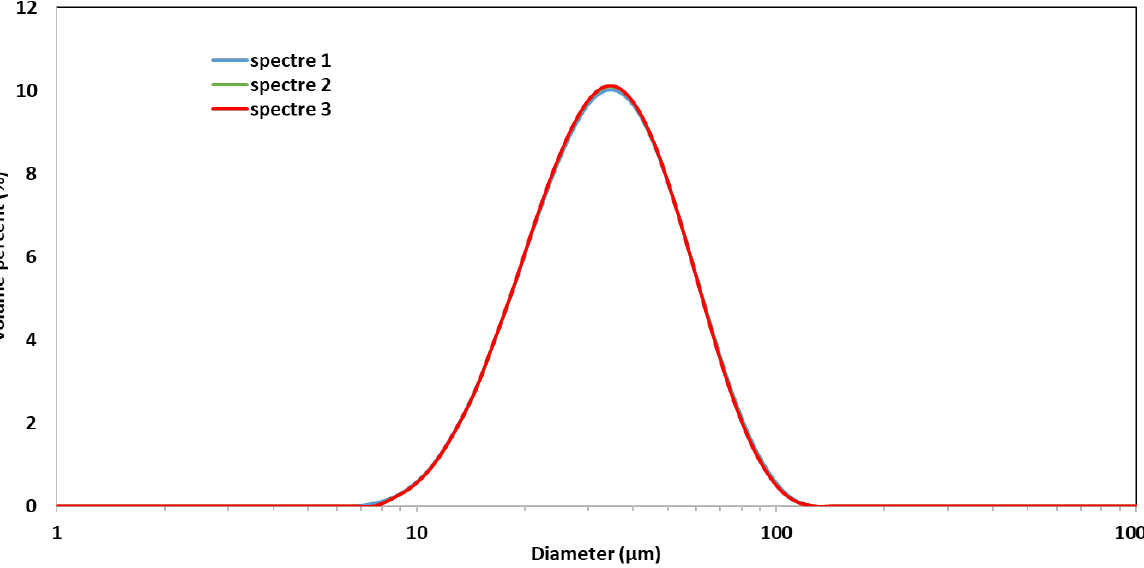
Figure 2. EOS 316L powder particle size distribution. The spectra from three measurements are practically overlapping.